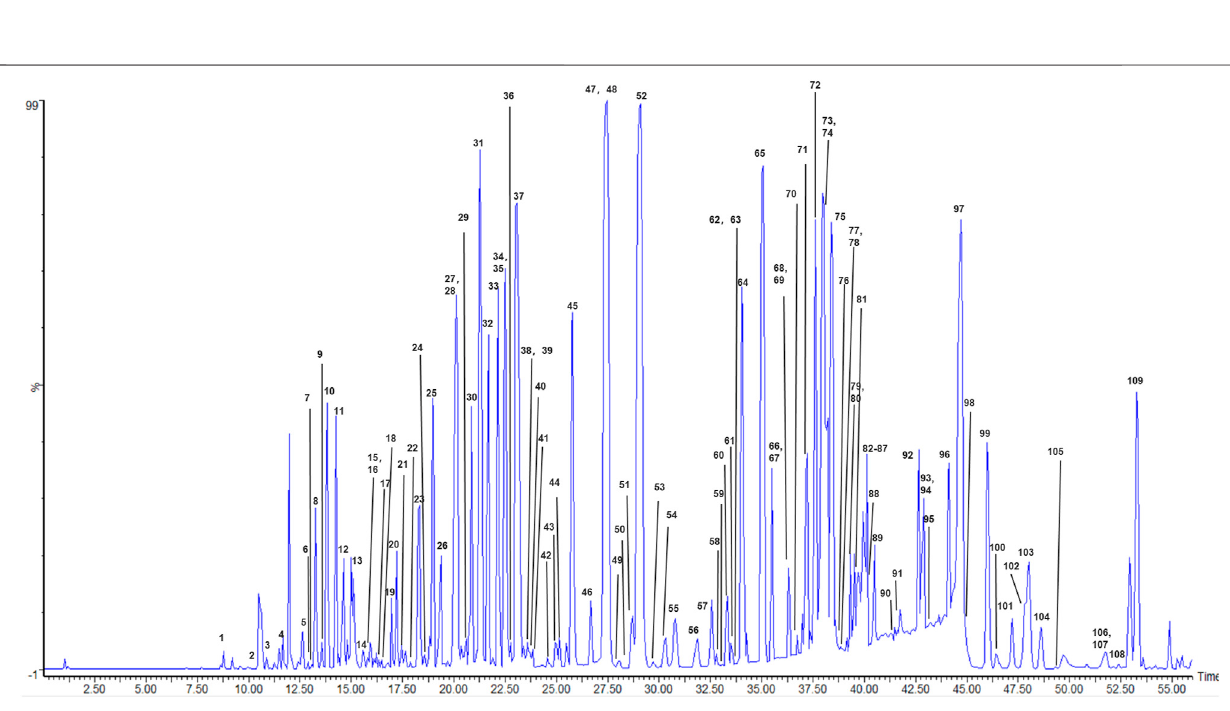
Frontiers in Chemistry |